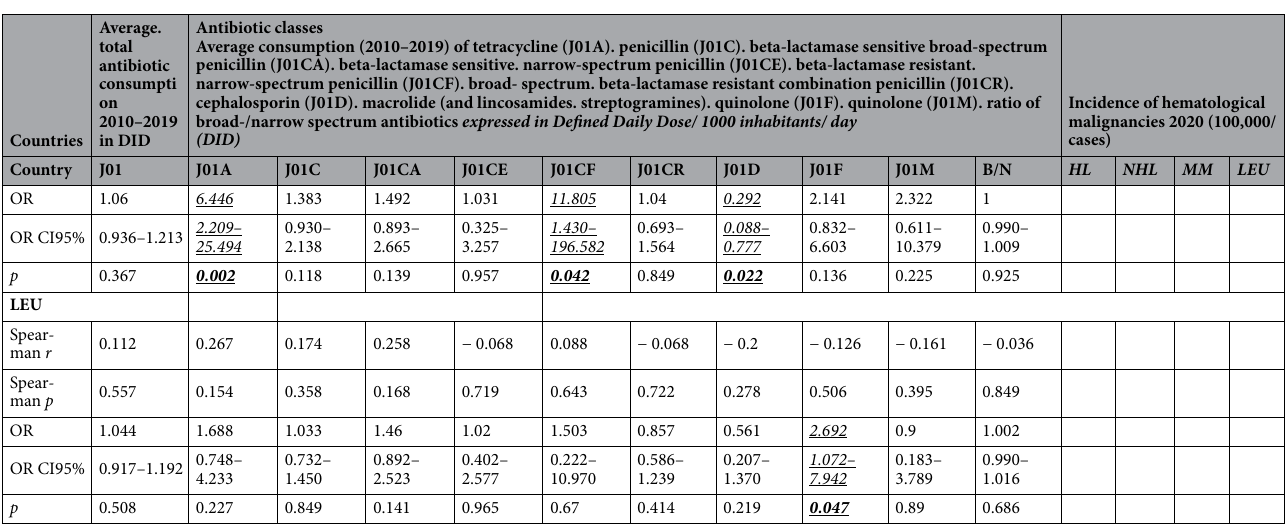
digestive tract can be estimated as @32 m 2 , of which about 2 m 2 refers to the large intestine 34 . The colonization of the intestinal lumen begins at birth and the composition of the gut microbiota is being influenced by several host and external factors and plays a crucial role in maintaining intestinal homeostasis, plays role in the maturation and education of the human immune system, protecting against the colonization of pathogen bacteria, respon- sible for energy harvest, production of nutrients and vitamins, metabolism of xenobiotics and procarcinogens. One of the most important scientific discoveries of recent years was the disclosure that the intestinal microflora